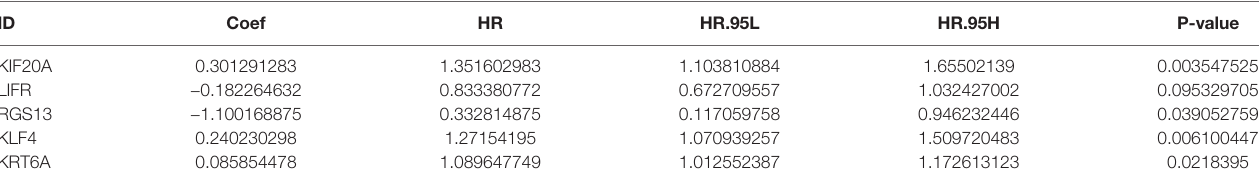
TABLE 2 | Multivariate Cox regression analysis of the 5-gene signature.